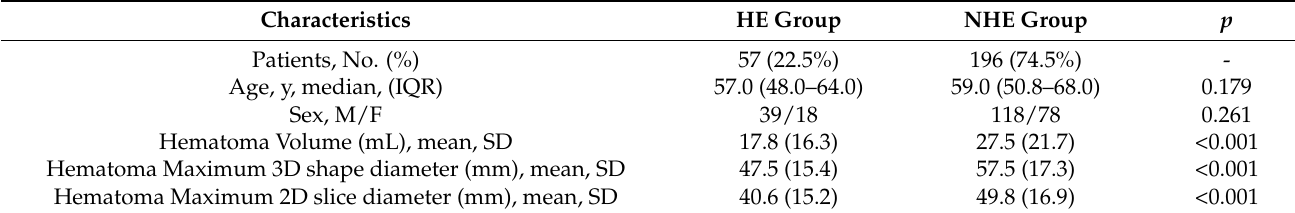
Table 1. Statistical results of clinical indicators of ICH patients.